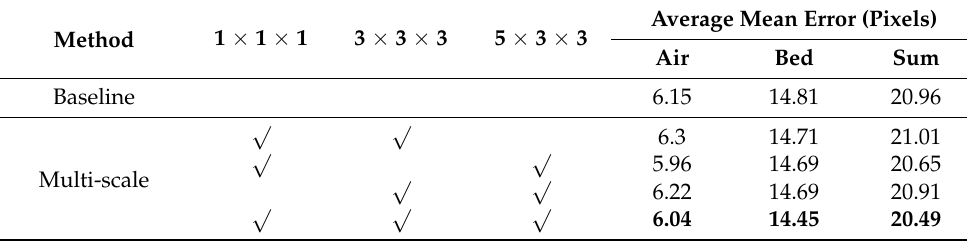
Table 3. Ablation study of filter sizes in branches in Msks. The symbol of ” which method is used.